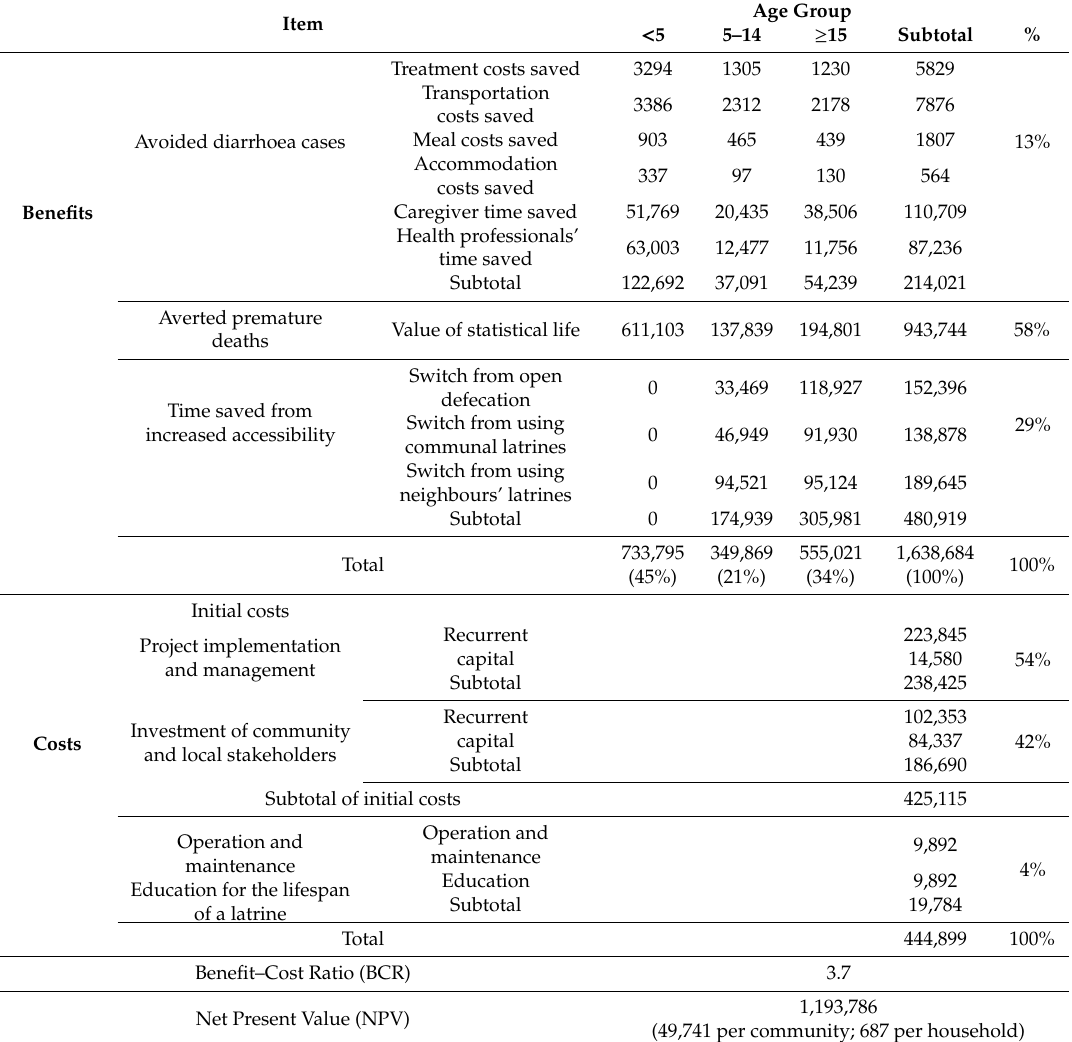
Table 3. Benefits and costs over 10 years (present value in 2016, Int’l